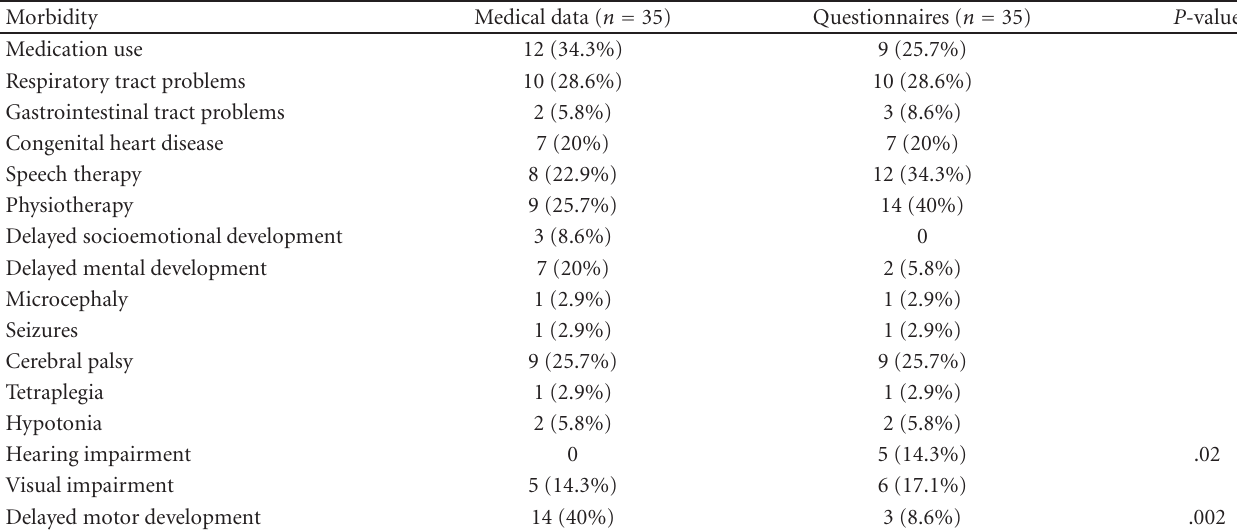
Table 5: Morbidity status of term